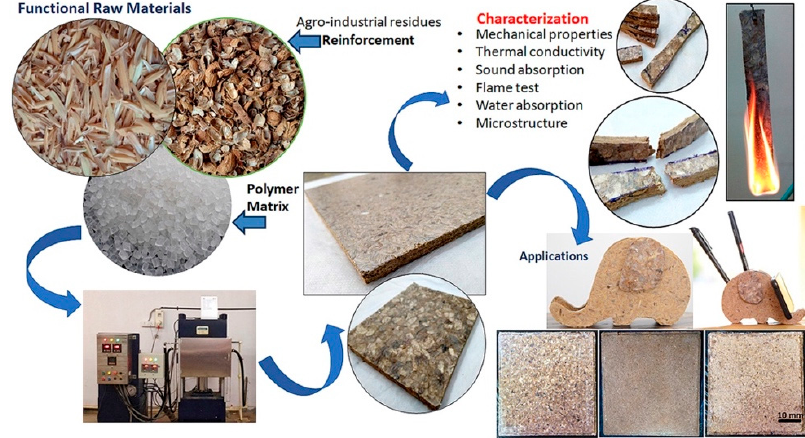
Figure 13. Reinforcement of hybrid polypropylene using rice husk and groundnut shells [3].